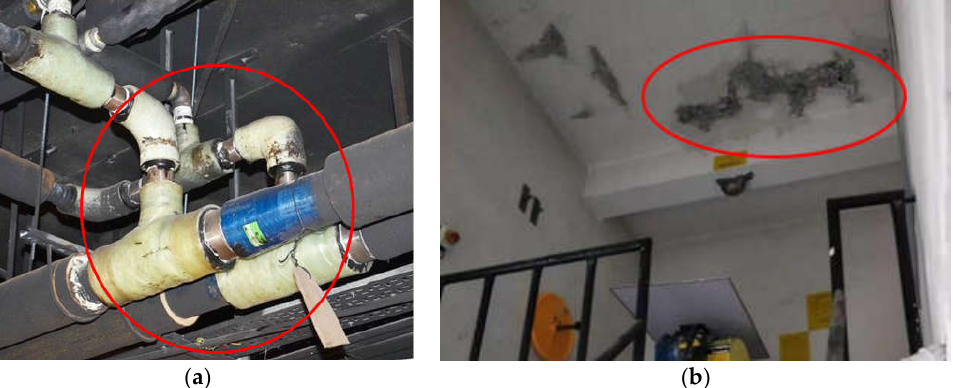
Figure 1. Common forms of damage to ACWS pipe networks: ( a ) leakage causes ACWS performance degradation; ( b ) ACWS water leakage causes